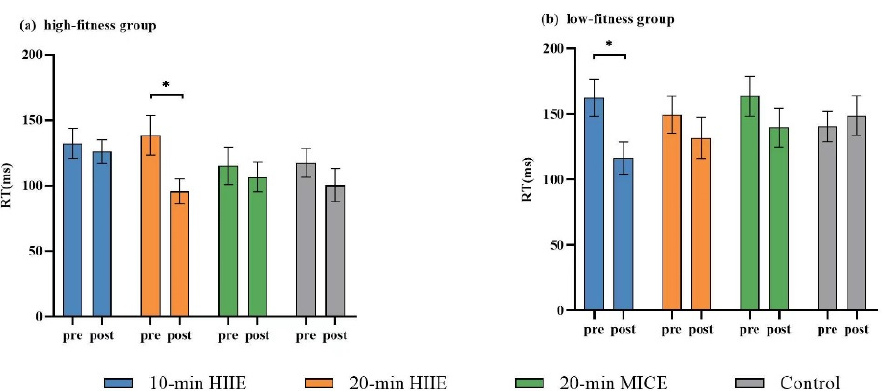
Figure 3. Switch cost for the high-fitness group ( a ) and low-fitness group ( b ) on the more-odd shifting task (* p < 0.0125 for Bonferroni correction).